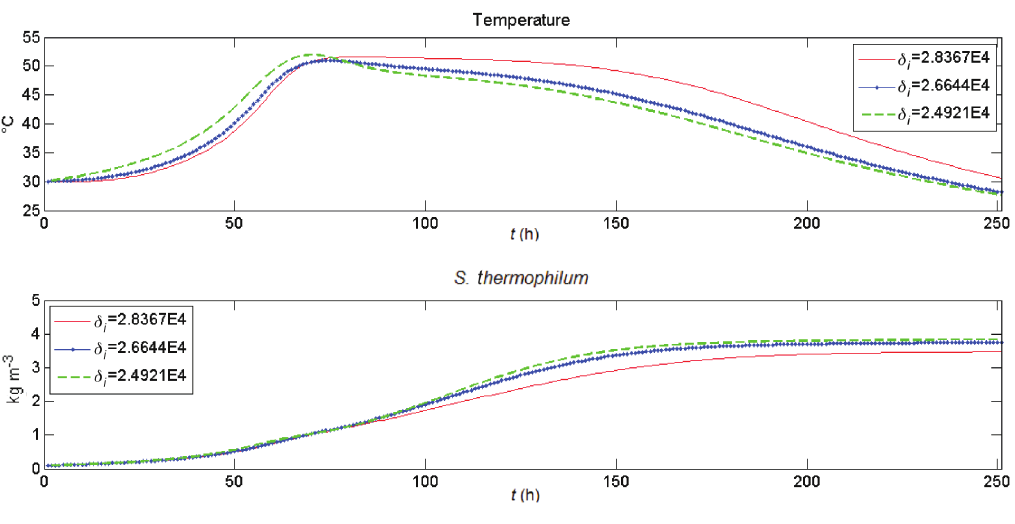
Fig. 15 – SSF model response with sensitive parameter δ